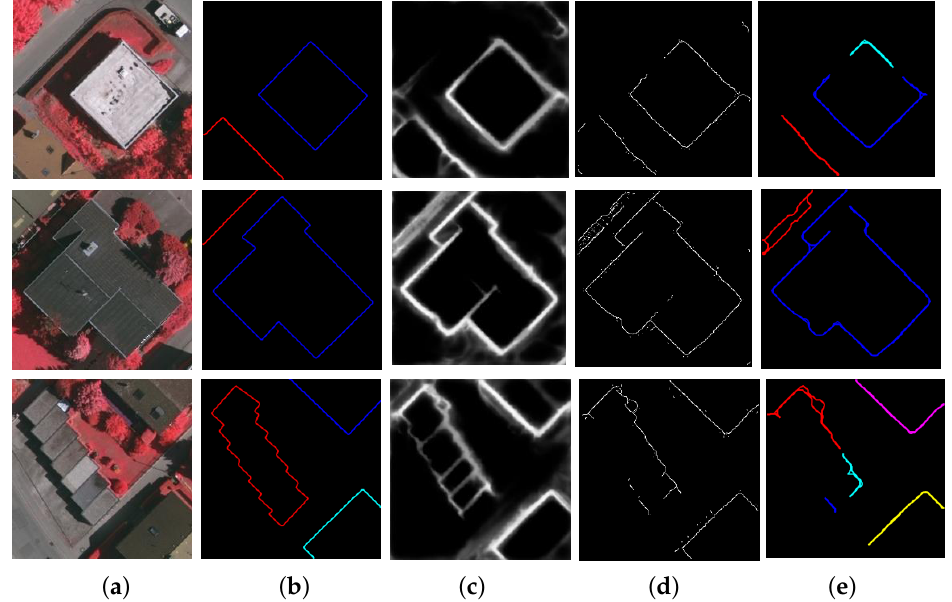
Figure 8. Building contour extraction in aerial images using the Richer Convolutional Features (RCF) [26]. ( a ) Test images; ( b ) ground-truth building contour curves; ( c ) RCF edge probability map; ( d ) RCF binary edge map; ( e ) Final results of the